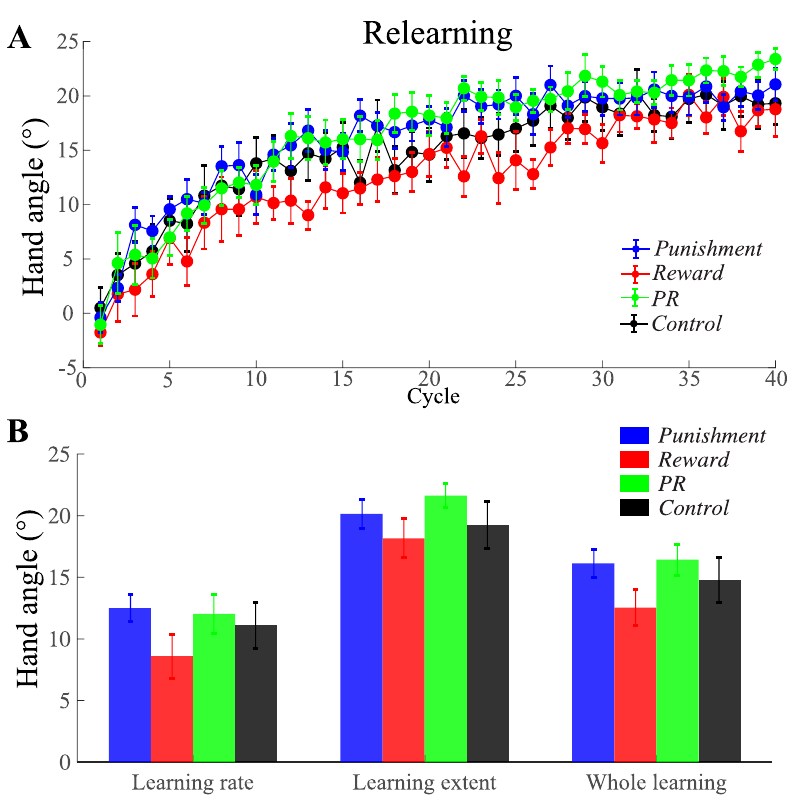
Fig 5. Comparison of the learning during the relearning phase from the four groups. A) The learning curves in the relearning phase of the four groups. B) Average learning rate, average learning extent, and average hand movement direction of the whole learning cycles for each group. Positive angle denotes CW direction. Error bars denote